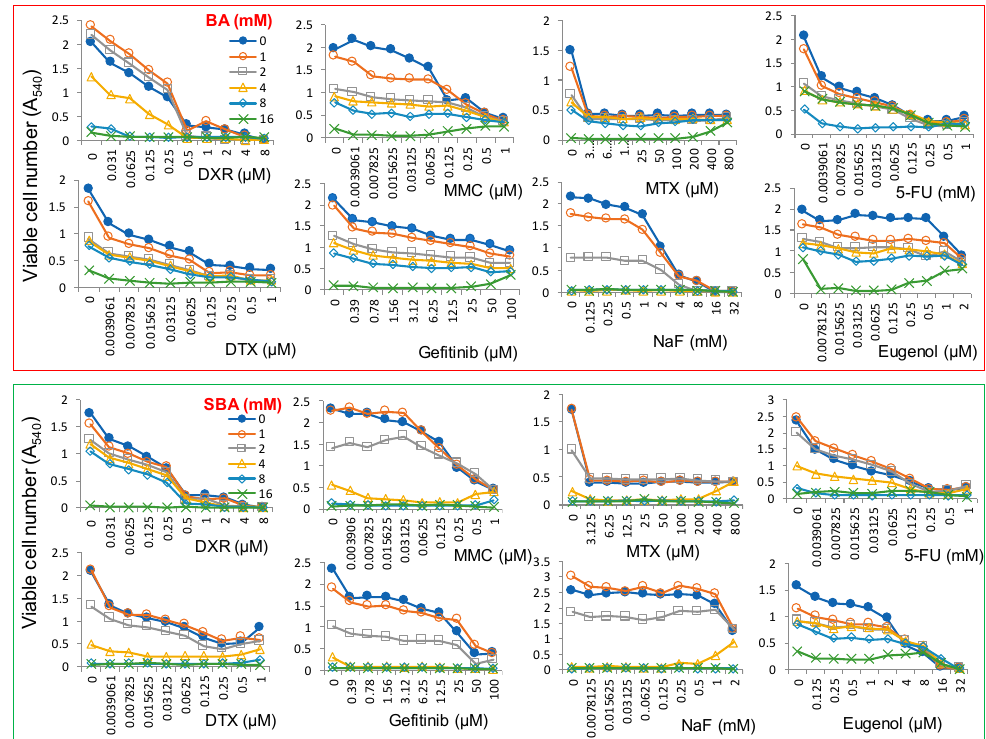
Figure 12. Combination effects of anticancer drugs and dental medicines on the augmentation of the cytotoxicity of BA (upper column) and SBA (lower column). HSC-2 cells were incubated for 48 h with the indicated concentrations of drugs in the presence of 0, 1, 2, 4, 8, or 16 mM BA or SBA, and the viable cell number was determined by MTT methods. Each value represents mean ± S.D. of triplicate assays. DXR, doxorubicin; MMC, mitomycin C; MTX, methotrexate; 5-FU, 5-fluorouracil; DTX, docetaxel; NaF, sodium fluoride.